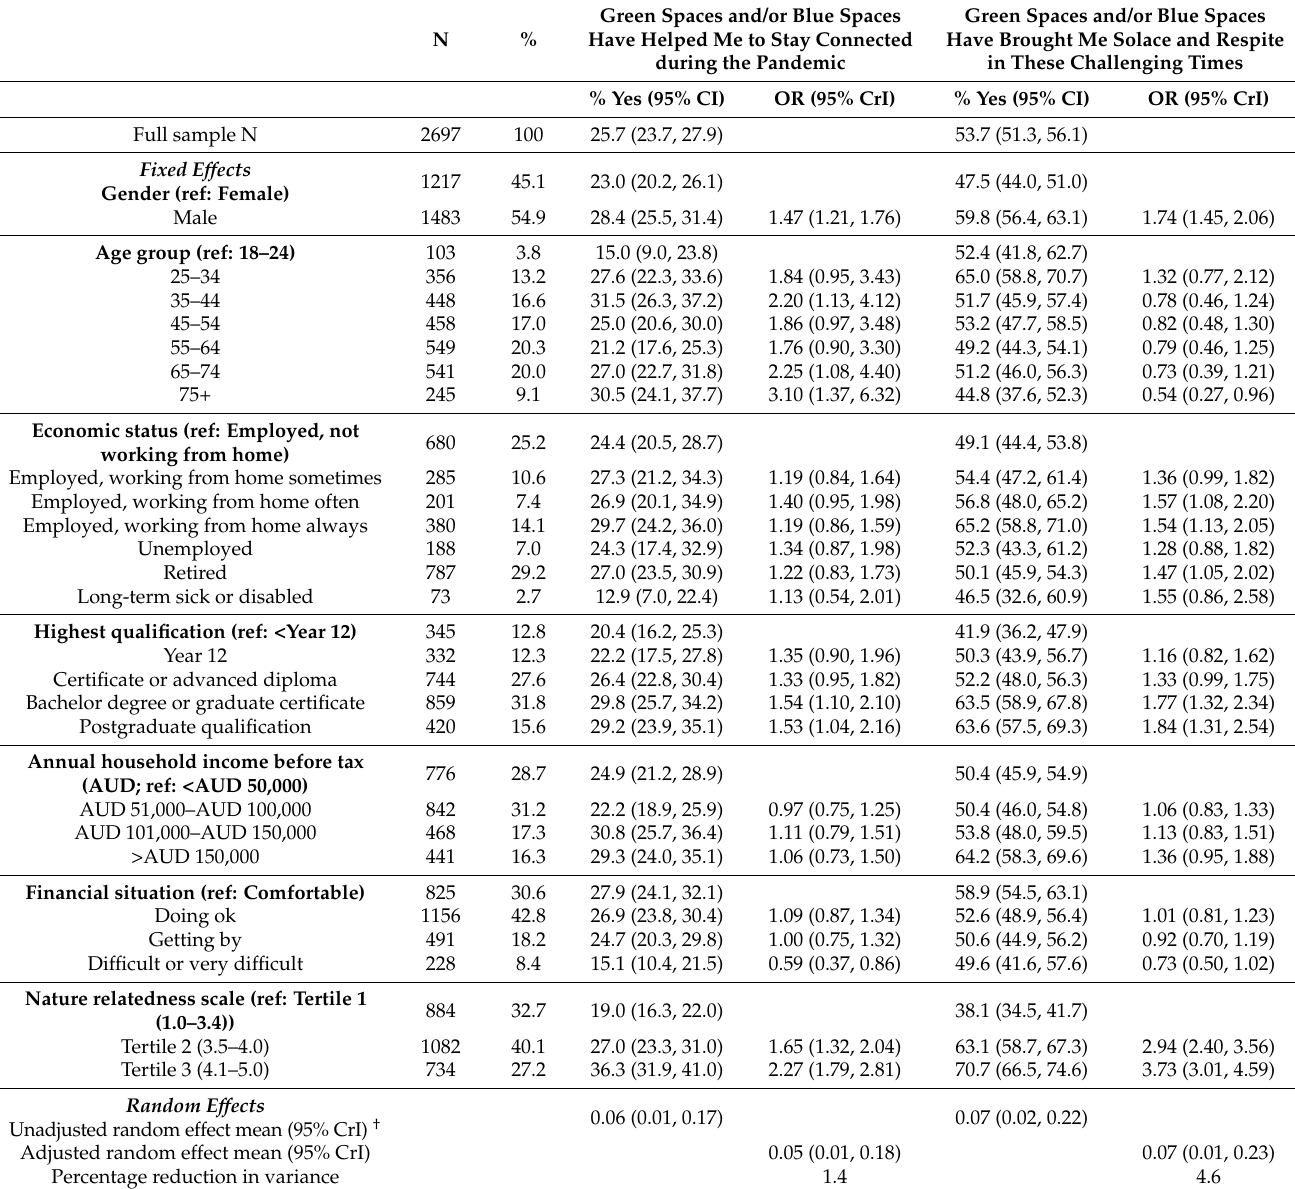
nature-relatedness scores. Participants who perceived their financial situation as difficult had lower odds of felt social connection resulting from visits to green or blue spaces. Table 5. Associations with social connection and solace in green/blue spaces during the COVID-19 pandemic. Green Spaces and/or Blue Spaces Green Spaces and/or Blue Spaces N % Have Helped Me to Stay Connected Have Brought Me Solace and Respite during the Pandemic in These Challenging Times % Yes (95% CI) OR (95% CrI) % Yes (95% CI) OR (95% CrI) Full sample N 2697 25.7 (23.7, 27.9) 53.7 (51.3,